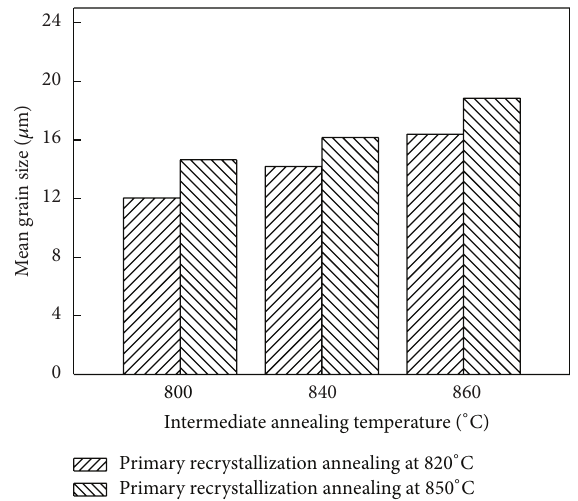
Figure2:Variationsofintermediatetemperatureonmeangrainsize of primary